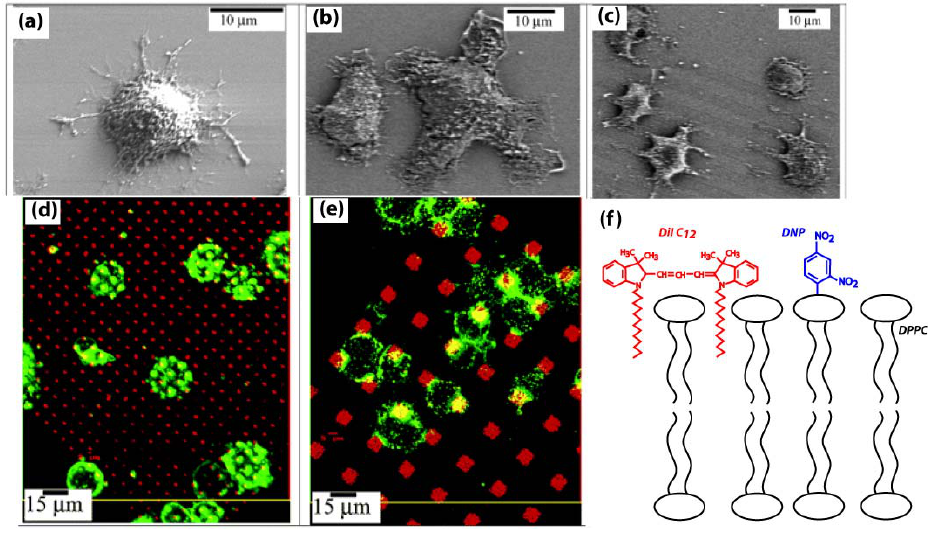
Figure 8. Scanning electron micrograph (SEM) images of RBL cells: (a) Resting RBL on a plain silicon surface with lamellipodia randomly spreading on the oxidised silicon substrate; (b) Stimulated RBL at the corner of four patterned squares of lipids; (c) Stimulated RBL over patterned lines of lipids. Gray lines indicate where the antigenic lipids were patterned. Interaction between RBL cells and the patterned lipid bilayer with (d) 1.5 μ m pattern, 5 μ m period, and (e) 6 μ m pattern, 16 μ m period. Confocal images of RBL cells sensitised with Alexa 488 anti-DNP IgE (green) on a 1,1'-didodecyl-3,3,3',3'- ) fluorescently labeled lipid bilayer (red). tetramethylindocarbocyanine perchlorate (DiIC 12 (f) Schematic showing composition of lipid bilayer patterned in (d): 1,2-dipalmitoyl-sn- glycero-3-phosphocholine (DPPC), 1,2-dipalmitoyl-sn-glycero-3-phosphoethanolamine-N- with molar ratio [6-[(2,4-dinitrophenyl)amino]hexanoyl] (DNP-cap-DPPE) and DiIC 12 94.5:5:0.5. Dinitrophenyl (DNP, blue) is the antigen for stimulating the mast cells, while DiIC (red) fluorescently labels the lipid bilayer. Adapted with permission from 12 reference [58]. Copyright 2003 American Chemical